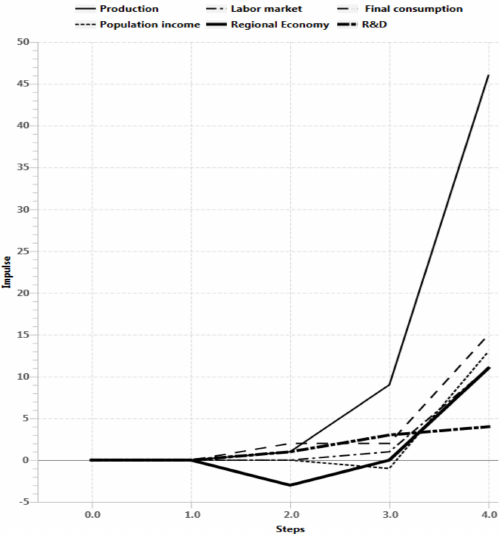
Figure 11. The graph of impulse processes at the selected vertices V1–V5, V20 Scenario "Improving the conditions of higher education and economical and political risks increasing" disturbing momentum q10 = + 1 and q16 = + 1.